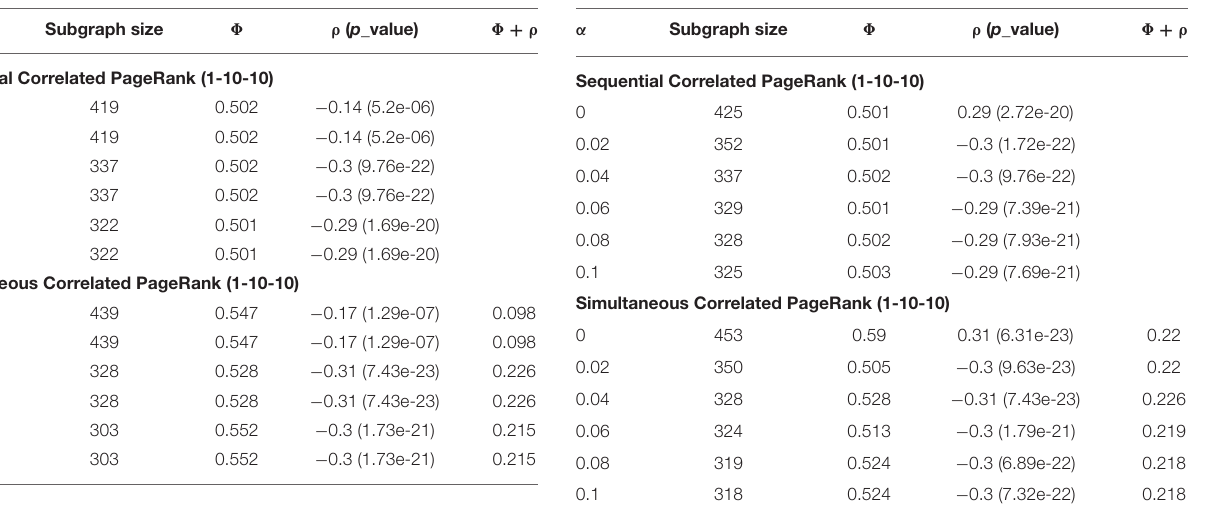
TABLE 2 | Teleportation effect on Correlated PageRank for 1-10-10 graph at ε = 1.0e-4 and seed =